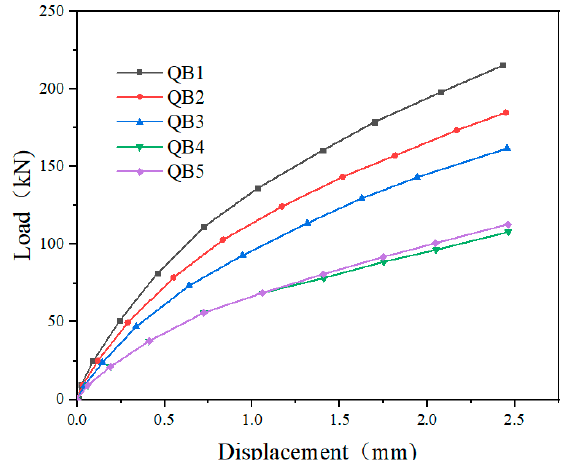
Figure 22. Load–displacement curves of the wallboard with different transverse spacings.